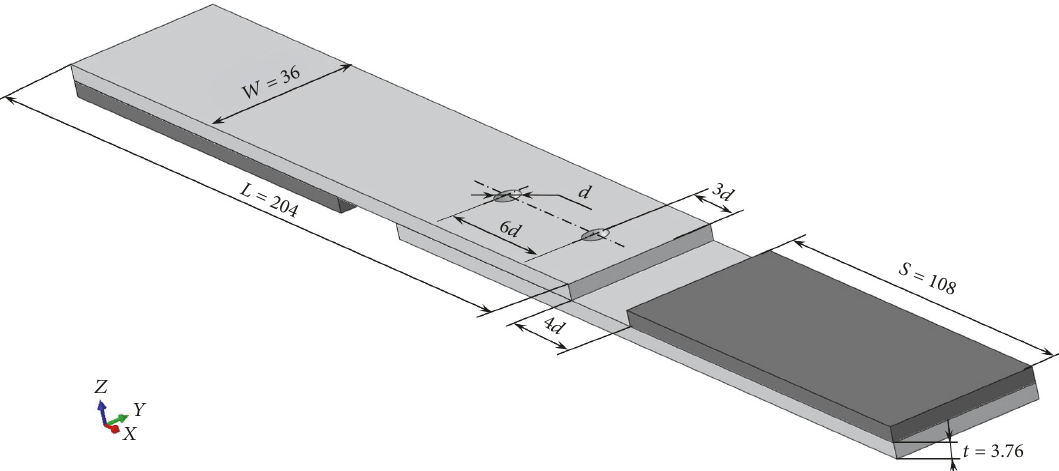
Figure 3: Configuration of specimens (unit: mm).